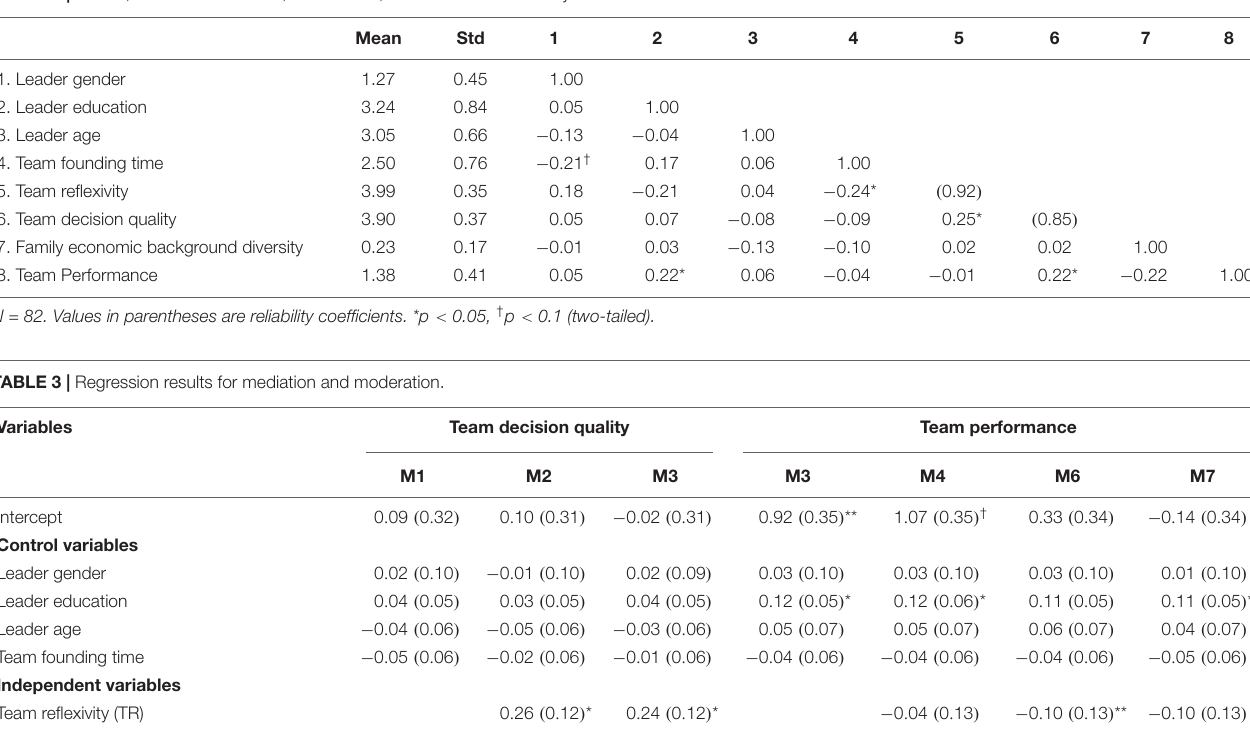
TABLE 2 | Means, standard deviations, correlations, and internal consistency reliabilities.